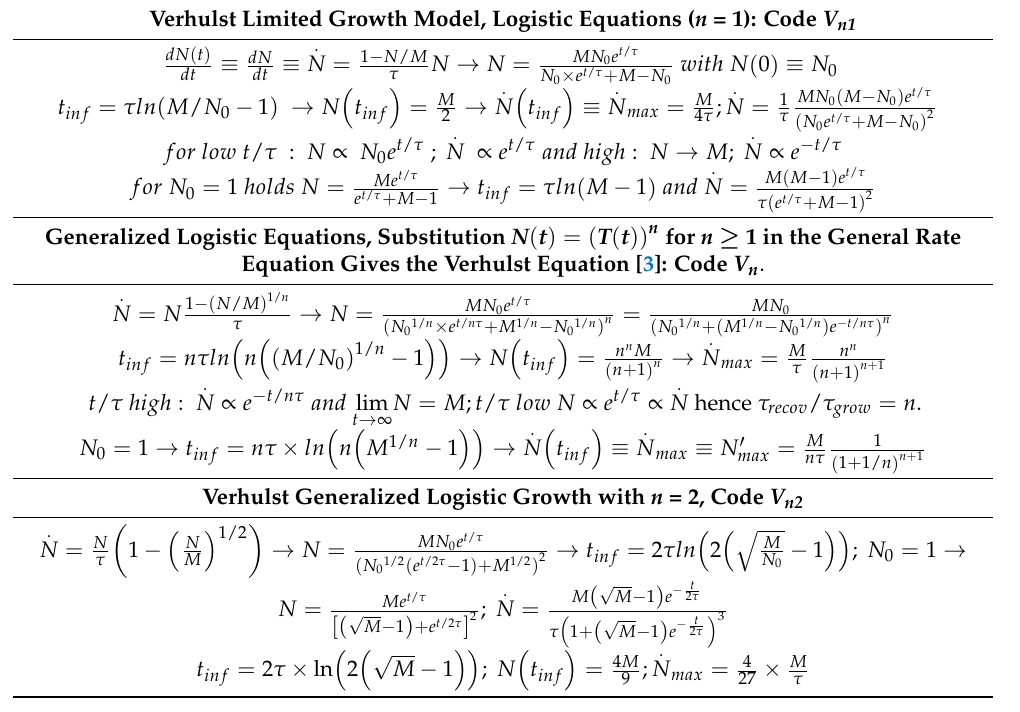
Verhulst Generalized Logistic Growth with n = 2, Code V n2 (cid:18) (cid:16) (cid:17) 1/2 (cid:19) . N → N N = N 1 − M τ